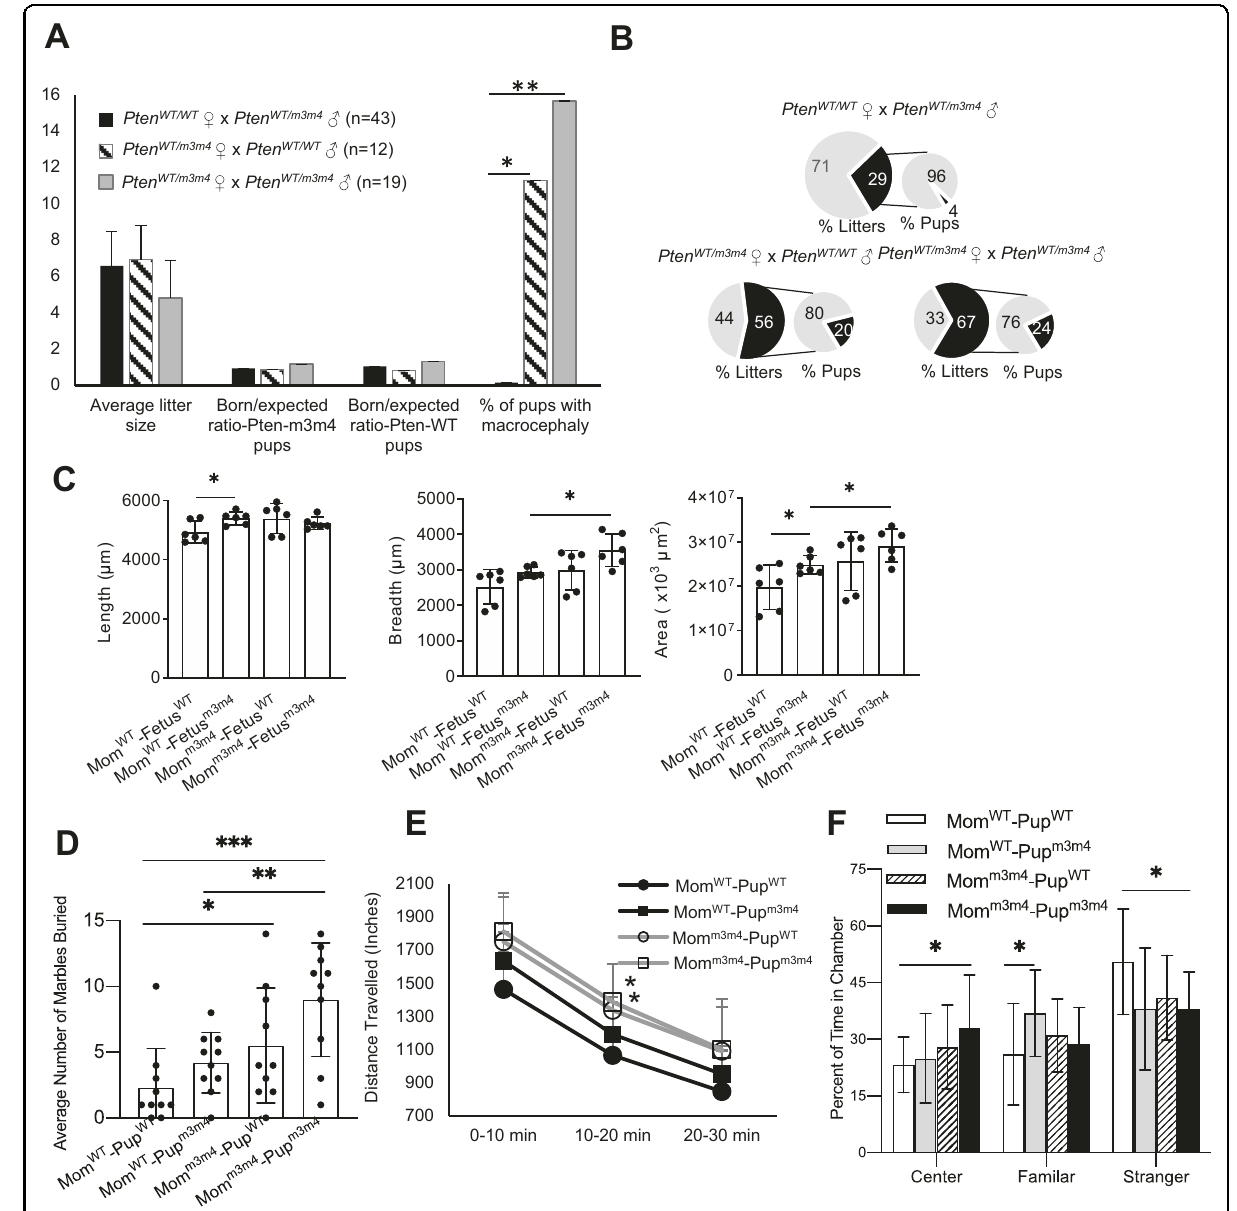
Fig. 1 Pups of Pten WT/m3m4 mothers have higher postnatal mortality, macrocephaly, and ASD-like behavior compared to Pten WT/WT